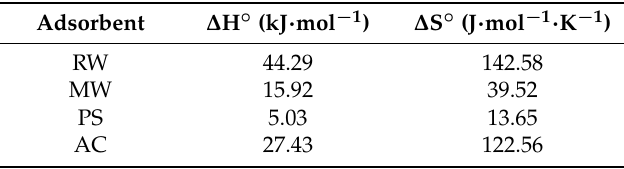
Table 3. Thermodynamic parameters for AB